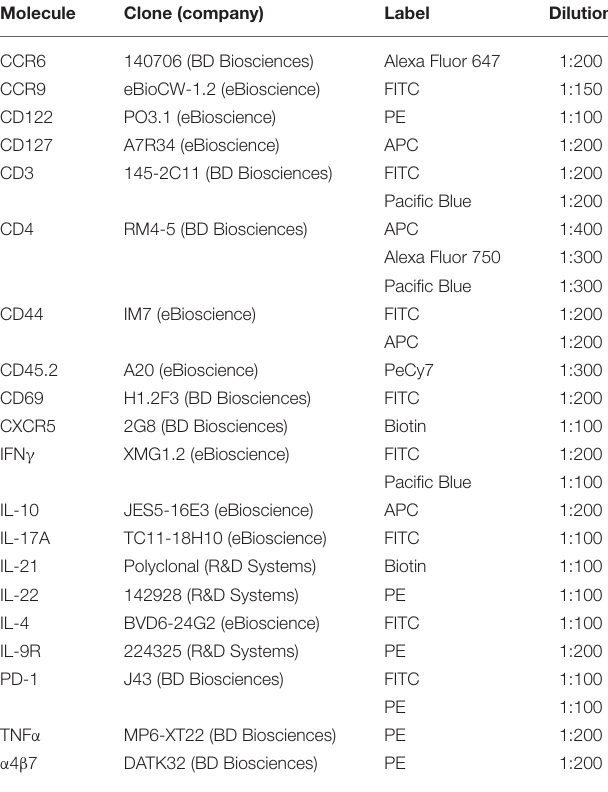
TABLE 1 | Antibodies for Flow Cytometry. Molecule Clone